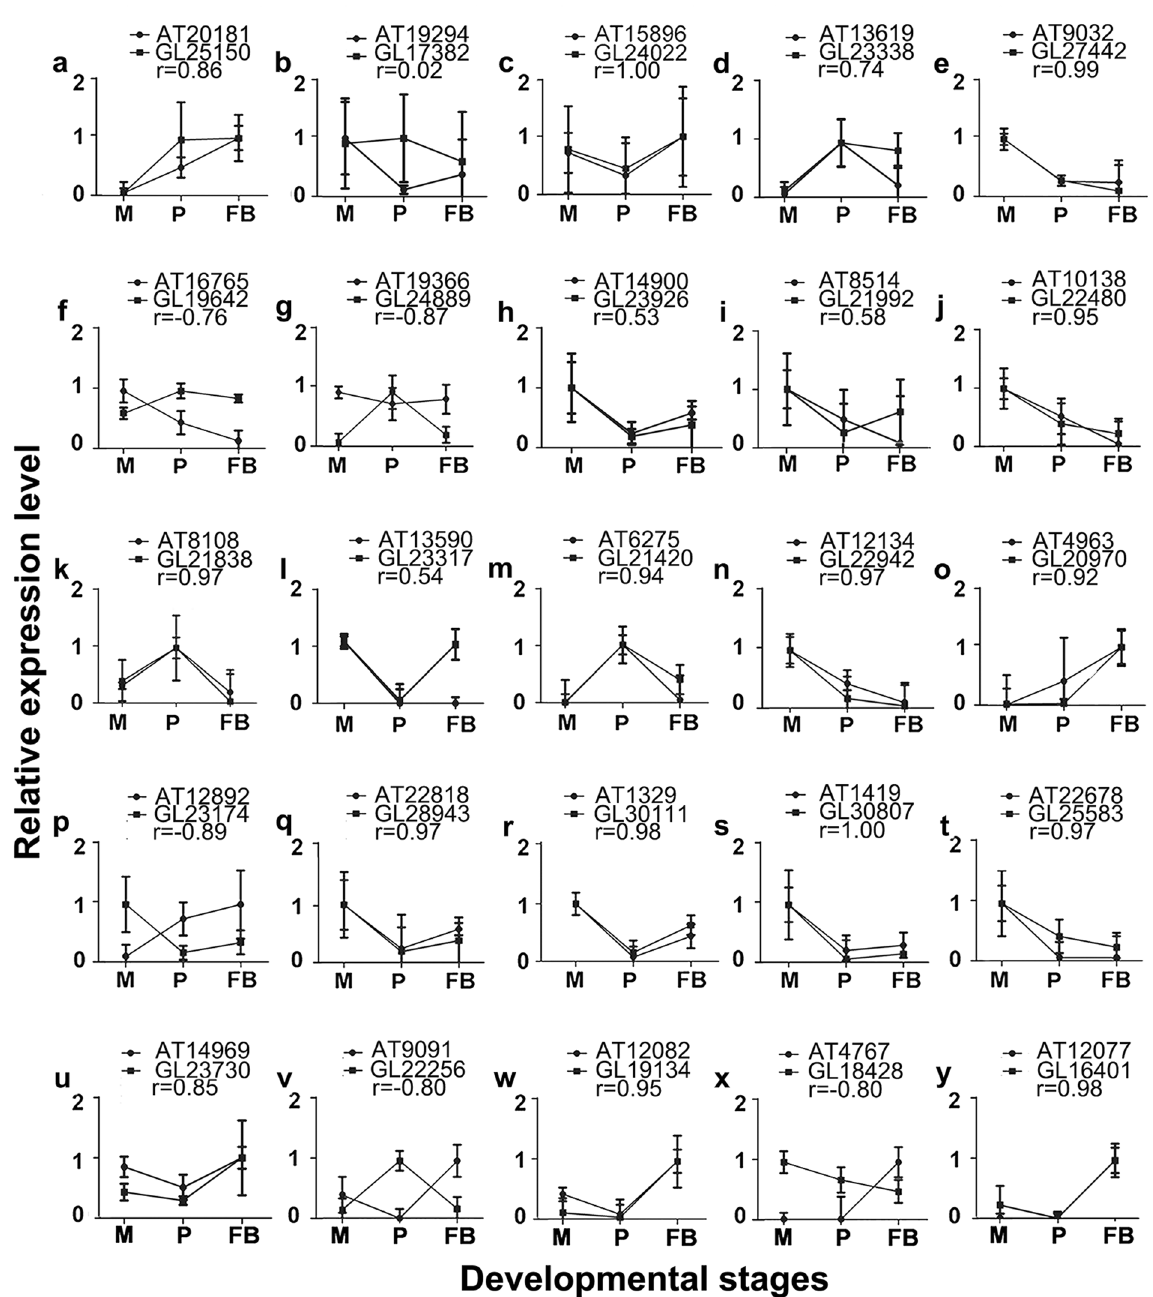
Figure 4. Correlation of expression profiles for NATs and STs. Panels a-t show the expression files of STs and NATs from 25 SAT pairs also described in Fig. 3. For each panel, the X axis indicates the corresponding developmental stage. The Y axis indicates the relative expression levels. The names of the ST, the NAT and the Pearson’s correlation coefficient between their expression profiles are shown at the top. The error bar denotes the standard deviations among the three biological replicates, each of which had three technical replicates in the ssRT-qPCR experiments. The details of the genes can be found in Table S9. M: mycelia; P: primordia; FB: fruiting